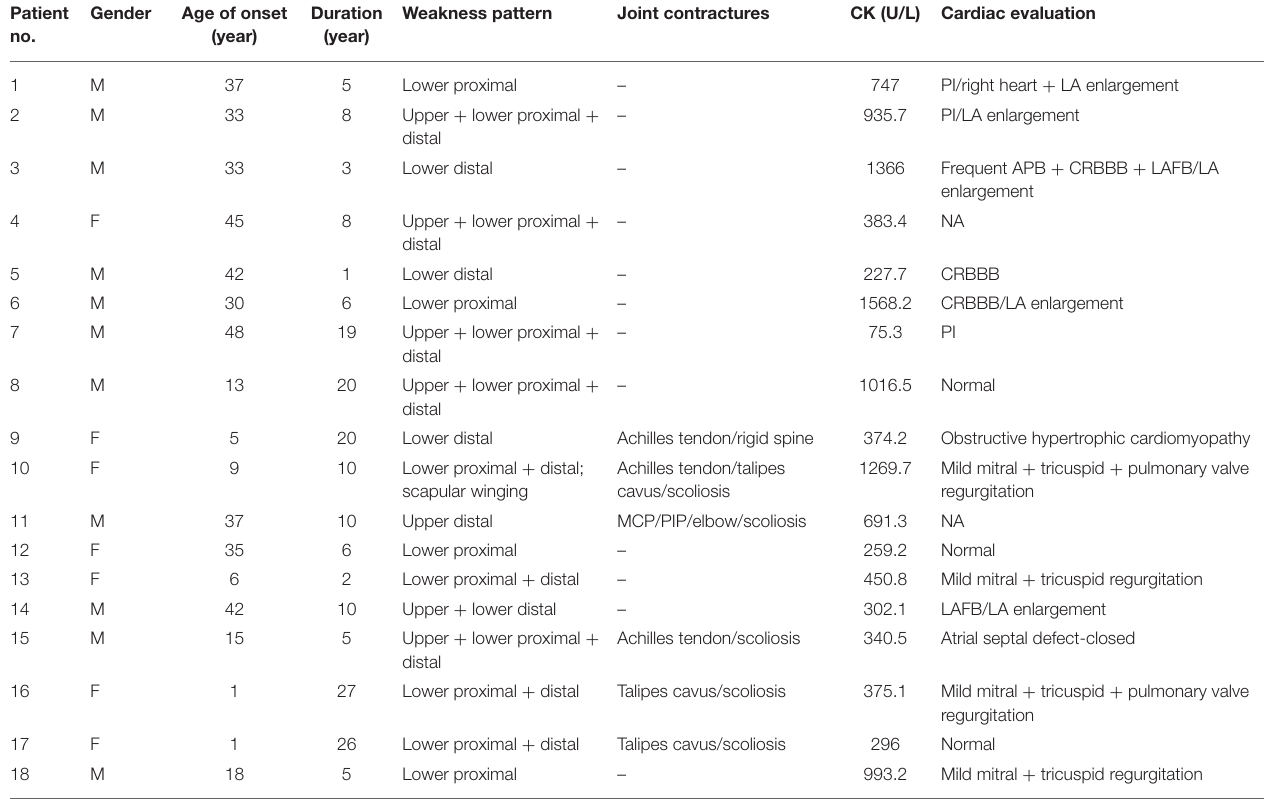
TABLE 2 | Clinical features of the present MFM patient cohort. Patient